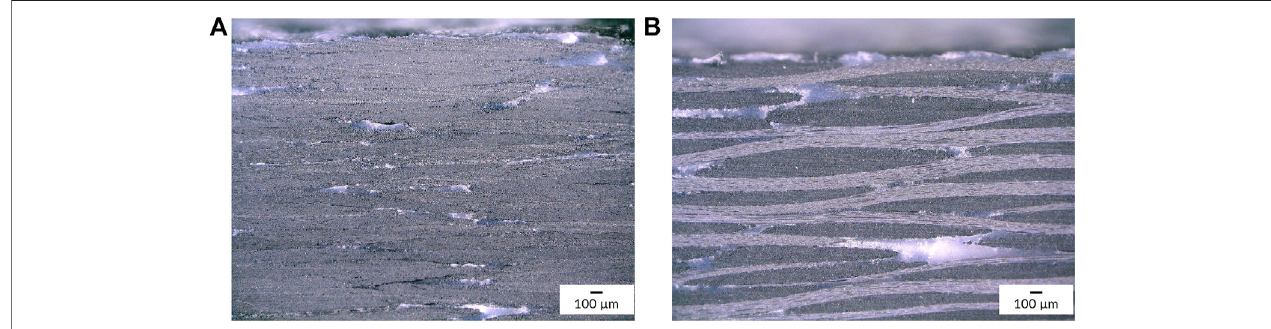
FIGURE 10 | (A) Optical microscopy image of the cross-section of a D2 [(+45/ − 45)] 18 sample showing signs of delamination and cracks; (B) a D2 [(+45/ − 45)] 18 sample was cut along fi ber direction at the impact location and the obtained cross-section was observed via optical microscopy: No broken fi bers can be observed.